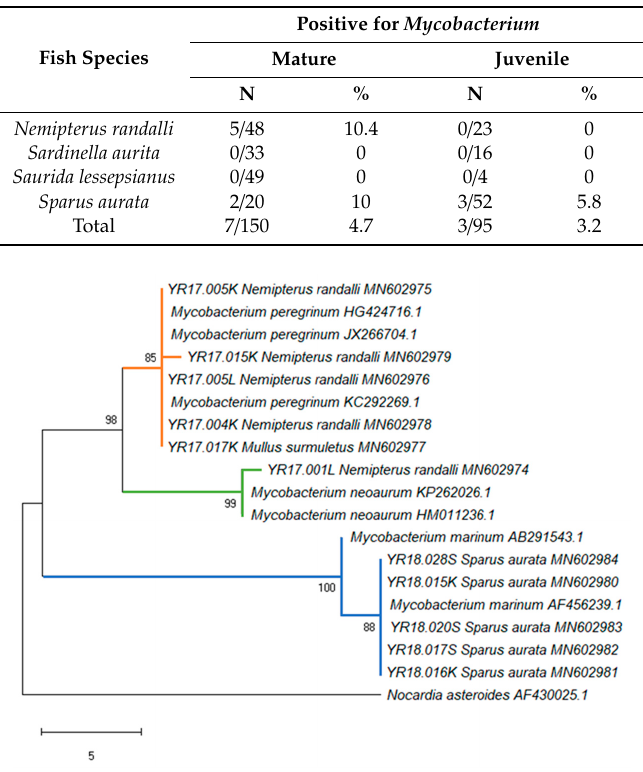
Figure 4. Mycobacterium sp. phylogenetic tree. Phylogenetic tree output from the Maximum Parsimony analysis of the Mycobacterium sp. derived from 16S rRNA gene partial sequences. The sequence